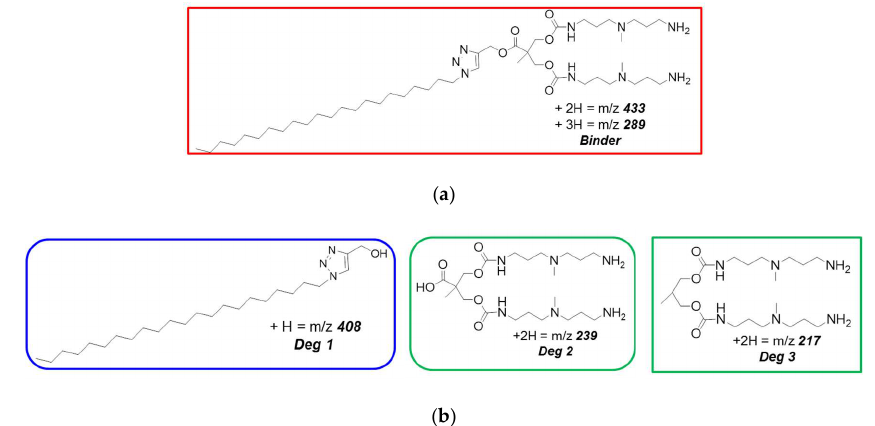
Figure 4. Structure of the molecular ions associated with the initially intact C 22 G 1 molecule ( a ) and